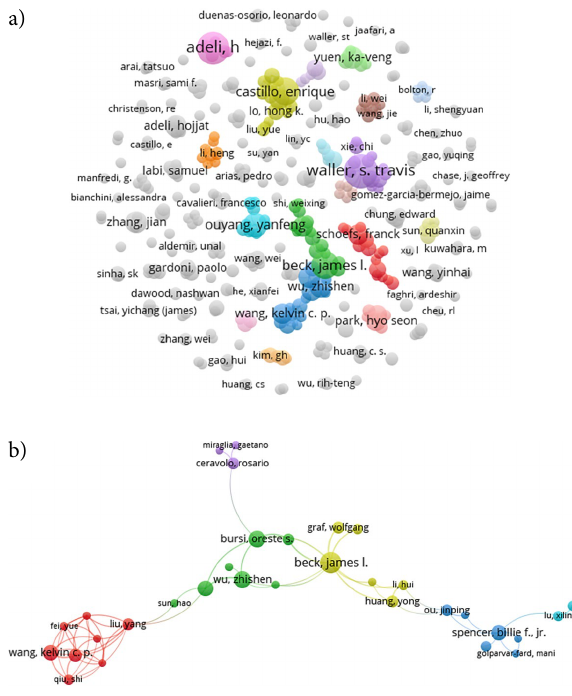
Figure 10. The collaboration network at level of author: